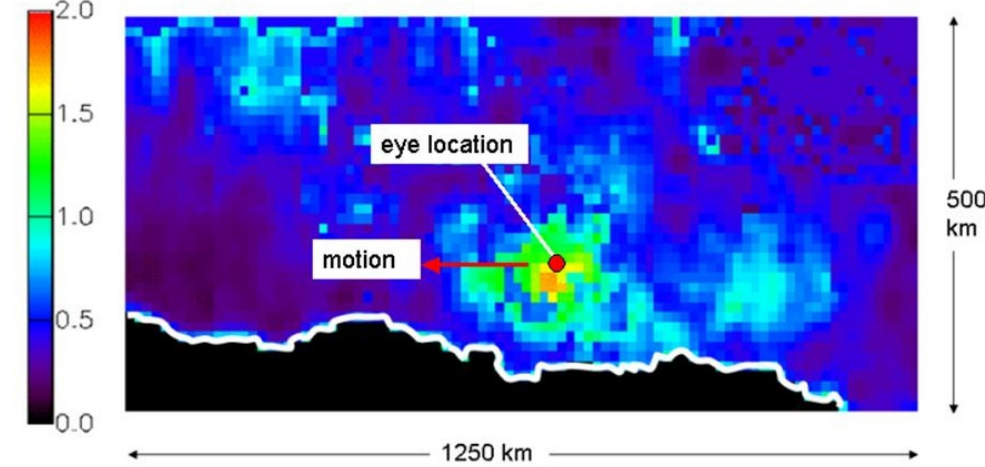
Figure 18. A skywave radar map of the wave height around a tropical cyclone, TC Victor, in 1986. The spiral band structure is very clear.